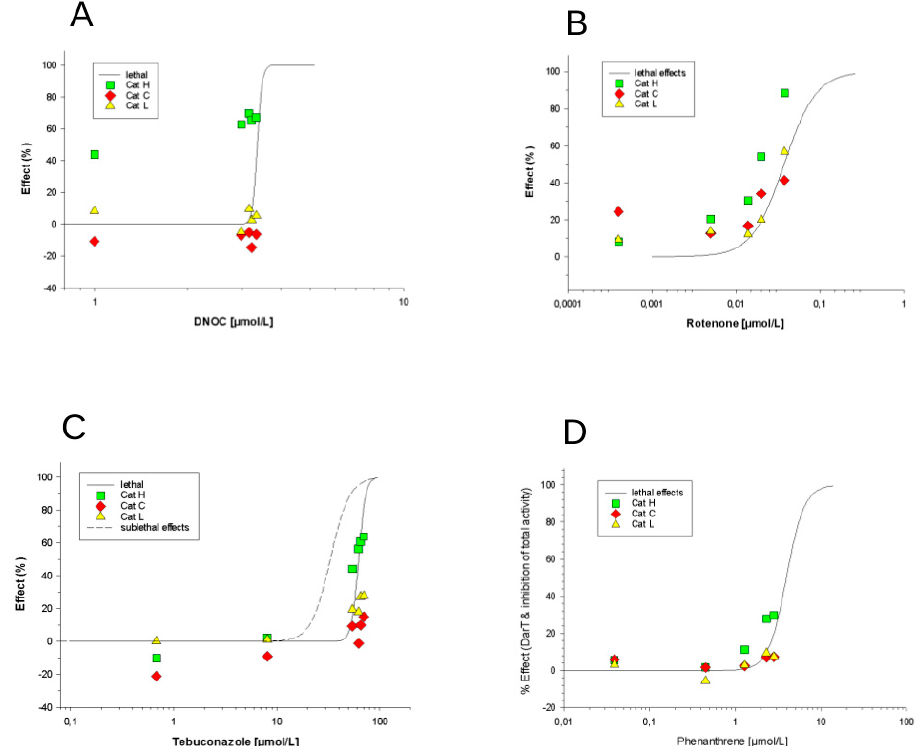
Figure 4. E ff ects of ( A ) DNOC, ( B ) rotenone, ( C ) tebuconazole and ( D ) phenanthrene on cathepsin activities in zebrafish embryos. CatH, C and L substrate conversion activities were measured at di ff erent toxicant concentrations and only concentration-dependent e ff ects are presented. All data points originate from homogenates of 60 intact embryos, not showing any phenotypic lesions. Data are shown in relation to observed phenotypic e ff ects obtained by FET (solid lines). For parameters, see Table 1.